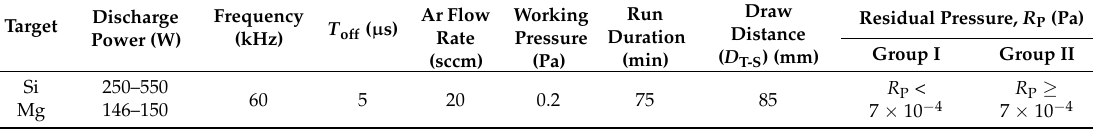
Table 1. Sputtering parameters maintained during deposition of Mg–Si